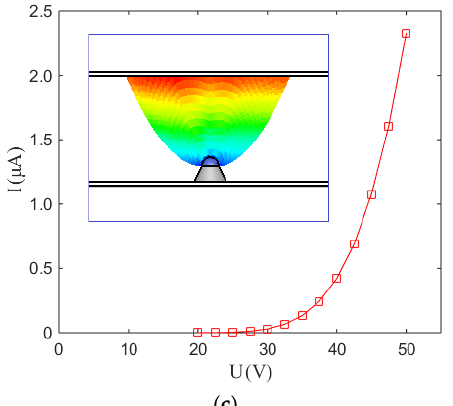
Figure 2. Single carbon nanotube (CNT)-coated Spindt field emission. ( a ) Surface electric field as a function of Spindt height. Inset: single Spindt geometry. ( b ) The maximum field enhancement factor β max , extracted from the geometry terms, as a function of h and r 1 . ( c ) Simulated emission from a single Spindt CNT cold cathode. Inset: beam trajectories.